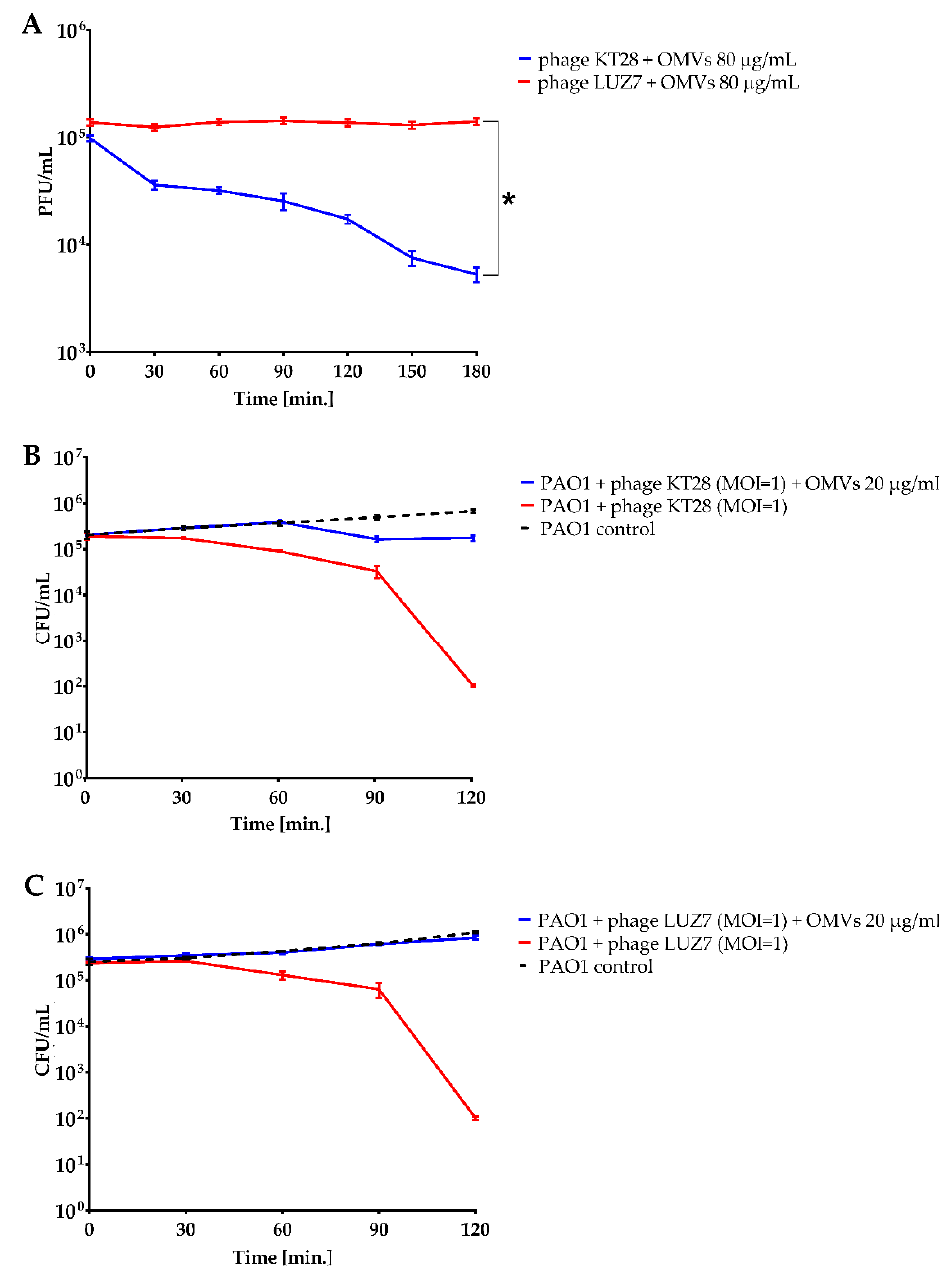
Figure 2. The inhibition of lytic phage activity by OMVs: ( A ) phage particles neutralization assay by OMVs at the concentration of 80 μ g/mL; the comparisons of AUC were performed by t -test for independent variables; * p < 0.0001. ( B , C ) The passive protection of P. aeruginosa PAO1 cells against lytic phage infection provided by free OMVs at 20 μ g/mL. The infection was monitored by the colony count of the surviving population treated with myovirus KT28 ( B ) and podovirus LUZ7 ( C ) at MOI = 1. The phage-uninfected PAO1 culture without the addition of OMVs was considered as the control. The curves were established on the average of at least two independent experiments performed in at least two working replicates, PFU/mL or CFU/mL measurement ± SEM bars. The passive protection with OMVs was confirmed in the second set of experiments for both cases, showing almost 100% of bacterial survival in the presence of phages and OMVs, whereas phage infected population in the absence of externally applied vesicles was reduced by over 3 logs for KT28 and LUZ7 phages (Figure 2B,C).